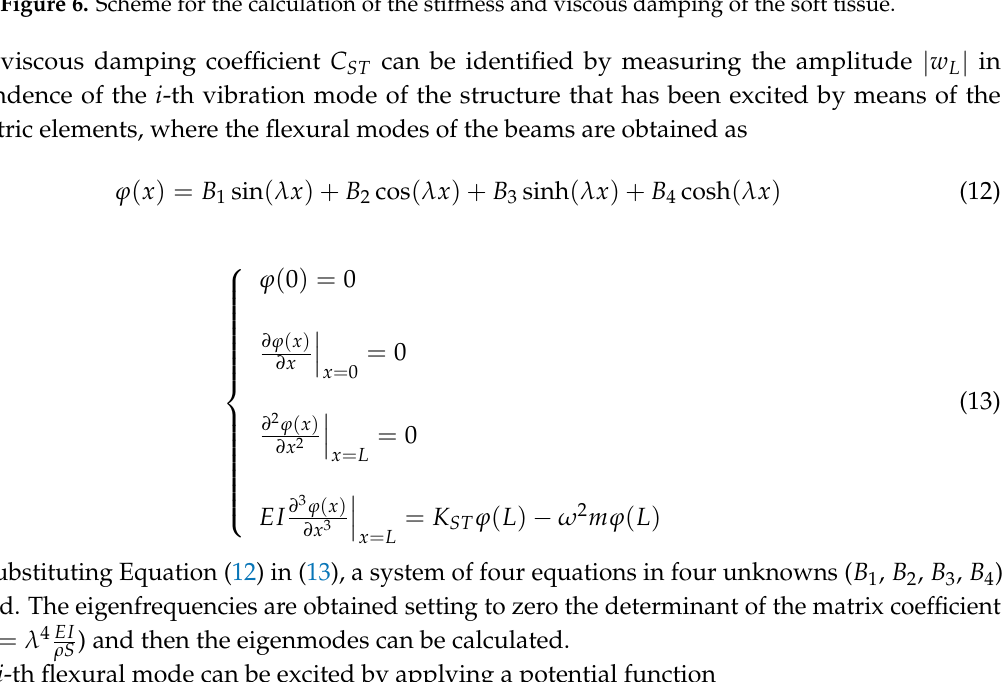
Figure 6. Scheme for the calculation of the stiffness and viscous damping of the soft